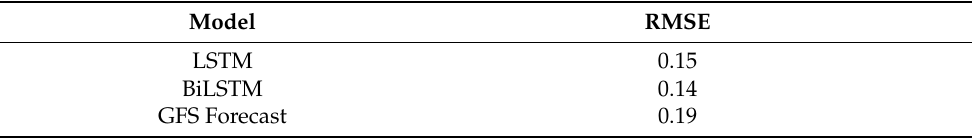
Table 4. Comparison between the significant wave height Hs from wave observation at Jakarta Bay with the results of GFS Forecast, downscaling using LSTM and